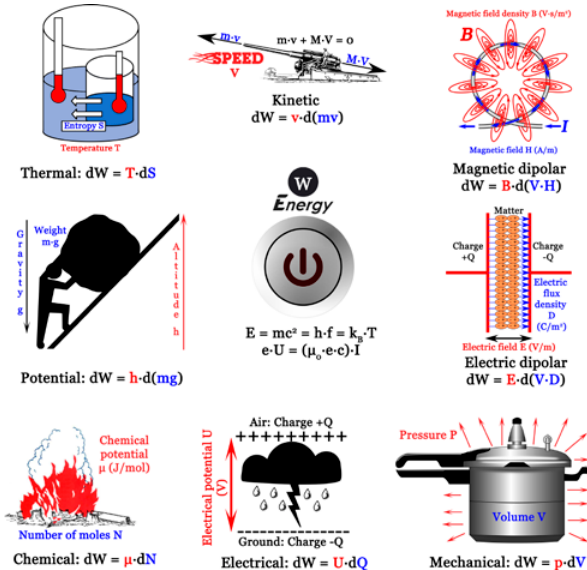
Figure 7. Eight common forms of energy in the observable M 4 space. In each case, energy corresponds to the product of a coor- dinate measuring an amount (highlighted in blue) by an associat- ed propensity (highlighted in red) taking at equilibrium the same value everywhere in the system. Other forms of energy not repre- sented here may also exists such as for instance interfacial energy dW = γ·dA where A is the coordinate measuring the amount of area and γ a propensity called surface tension. One may also cite elastic energy, dW = x·d(k·x) where k·x is the coordinate measur- ing the amount of tension and x the propensity corresponding to a length. In fact it exists an infinite number of energy forms accord- ing to the meaning given by consciousness to the manifestation of information activity. One may thus even define a psychic energy, dW = ψ·dN, where N is the coordinate measuring the amount of thoughts and ψ the associated propensity that could correspond to the intensity of desire for